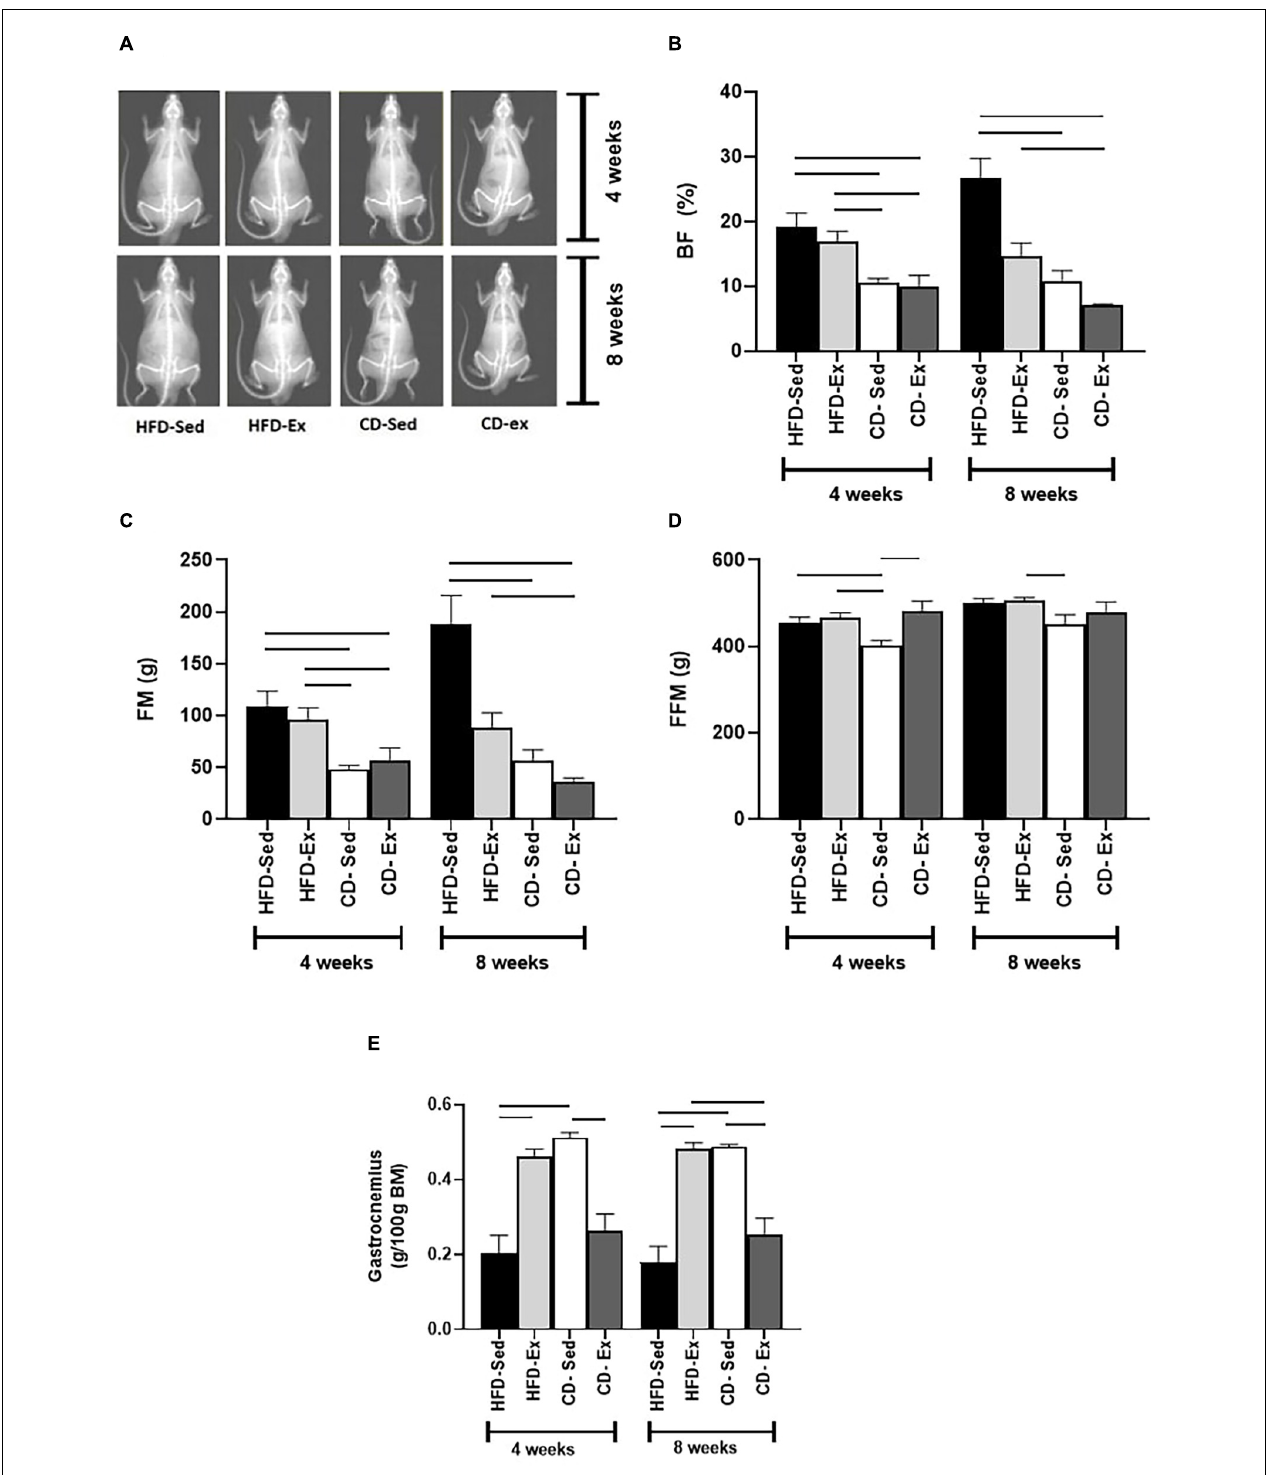
FIGURE 4 | Effects of diet and exercise on body composition. (A) DXA images of high-fat diet (HFD) and chow diet (CD) groups. (B) Body fat (%) was assessed after 4 and 8 weeks. (C) Fat mass was determined at weeks 4 and 8. (D) Fat-free mass was registered every 4 weeks. (E) Gastrocnemius mass was assessed at 4 and 8 weeks. The bars represent the significant differences between the groups indicated. HFD-Ex: high-fat diet and exercise; HFD-Sed: sedentary high-fat diet; CD-Ex: chow diet and exercise; CD-Sed: sedentary chow diet. The bars represent the significant differences between the indicated groups. Results are means ± SEM ( p <